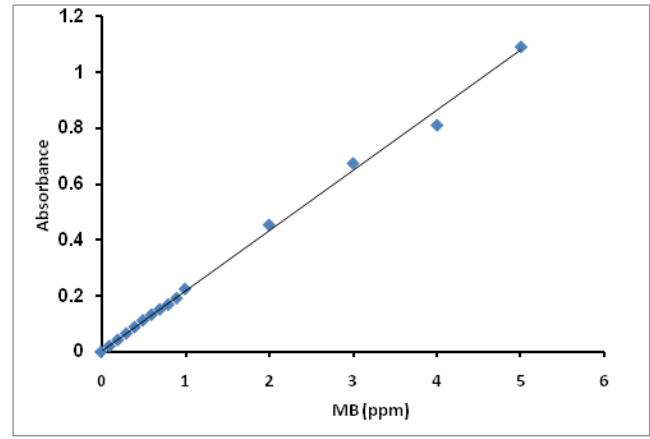
Figure 14. Standard curve for MB concentration.